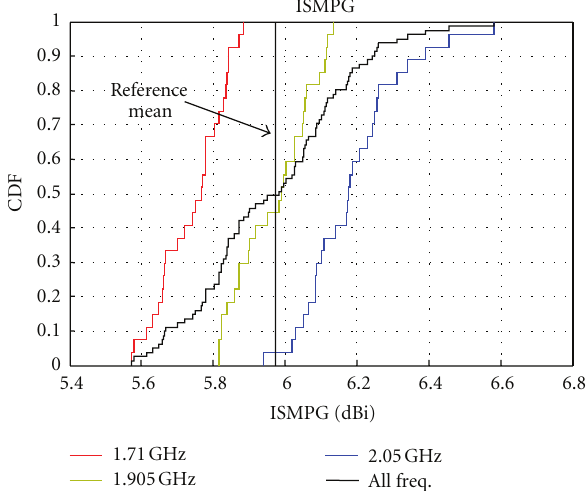
Figure 11: ISMPG distribution over all realizations for the patch- wall parallel scenario.